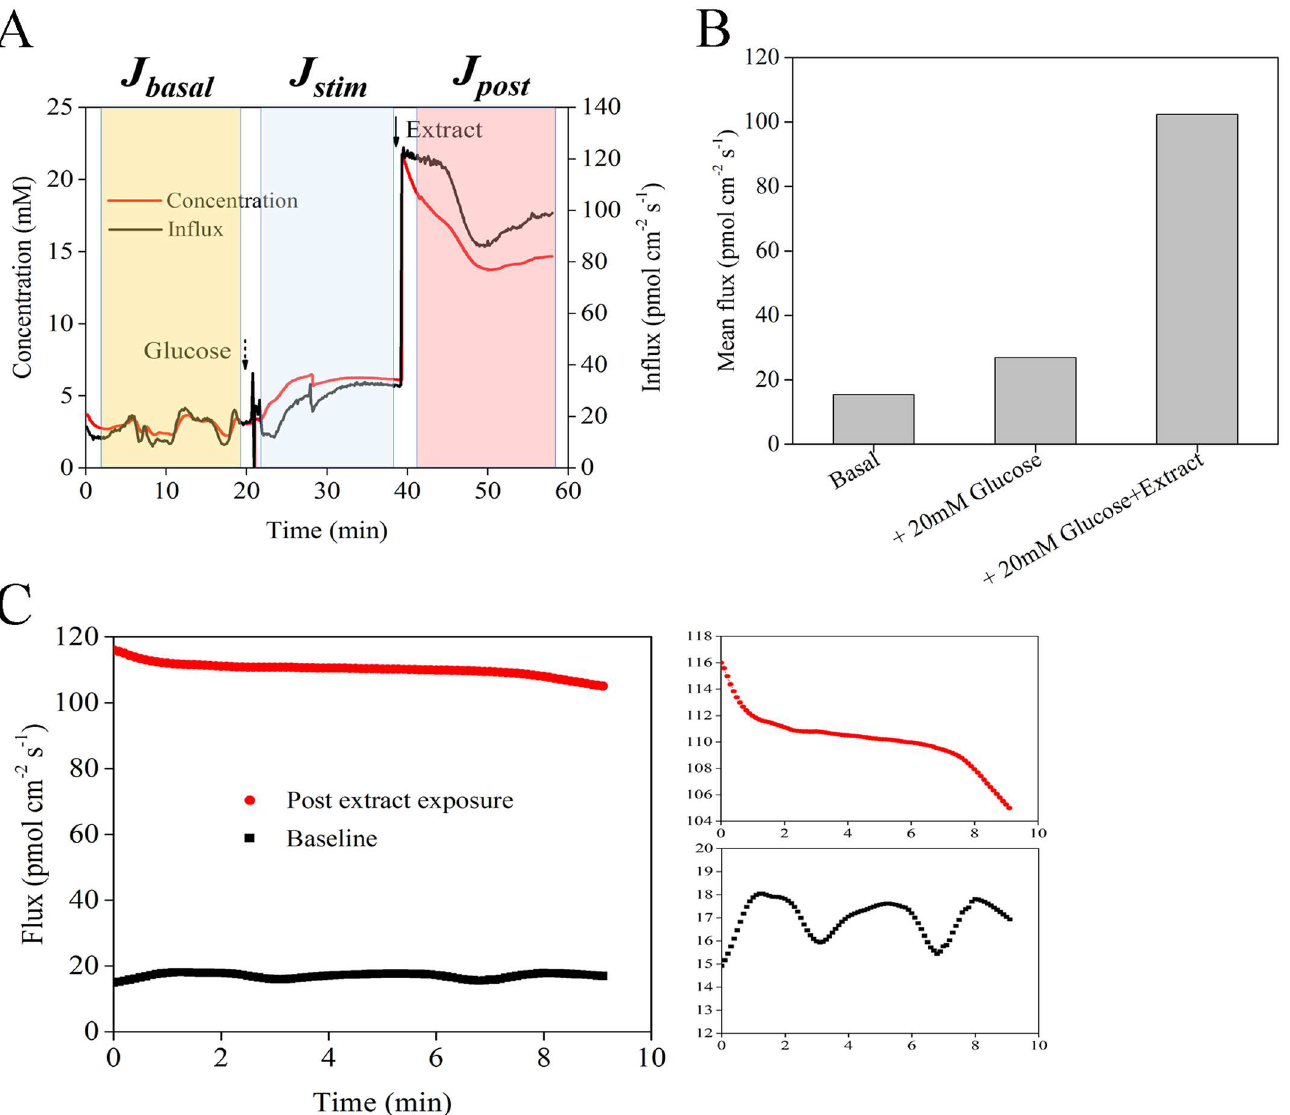
Fig 5. A representative example of glucose flux and concentration, and mean flux. (A) Representative sample showingglucoseinflux for a tissue taken from the flavonoidgroup (no exogenous insulinadded). After additionof 20 mM exogenous glucose(shown by a dashedarrow), glucoseuptake graduallyincreased(blue highlighted section). After additionof drug, an immediateand significantincreasein glucoseflux occurred, and flux stabilized at this level (red highlightedsection). (B) Mean flux of glucosein J basal , J stim , and J post . (C) Representative glucoseoscillations before and after addition of glucose+extract. Prior to exogenous glucoseaddition,regularultradianoscillations in glucoseflux, but these waves were dampened after additionof glucose/extract.